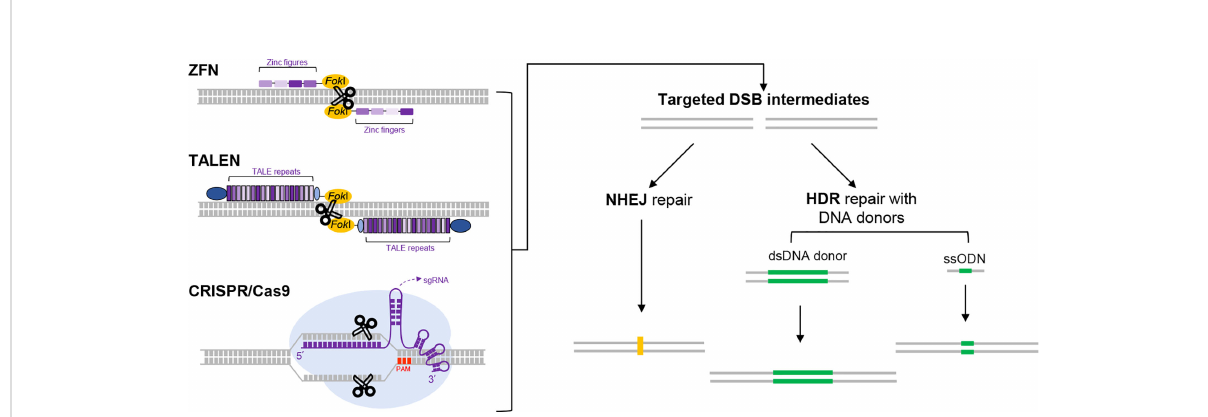
FIGURE 1 The use of programmable nucleases for genome editing. Three major programmable nucleases, i.e., ZFNs, TALENs and CRISPR/Cas9 are schematically illustrated on the left part. ZFNs and TALENs are respectively composed of sequence-speci fi c DNA-binding protein modules linked to a nonspeci fi c DNA cleavage domain (derived from Fok I endonuclease). In ZFNs, an array of zinc fi gures (small blocks in different shades of purple), each speci fi cally recognizing a 3-bp of DNA sequence, are assembled in tandem to program a speci fi c DNA-binding event. In TALENs, variants of TALE repeats correspond to each of the four single bases. Therefore, programmed DNA binding by TALEN is enabled by an assembled array of TALE repeats (dense purple bands). Two other constant domains in TALEN are also depicted in dark and light blue, respectively. For DNA cleavage to occur, the Fok I domain requires dimerization. As a result, only two adjacent targeting events by a pair of targeting ZFN or TALEN monomers in correct orientations would trigger double-strand break (DSB) at a speci fi c locus. The mechanistic principle for CRISPR/Cas9 (a prototype for many CRISPR/Cas tools) is different from those for ZFNs and TALENs. It employs a Cas9 protein and an engineered guide RNA. The Cas9 protein features two nuclease domains, each responsible for cleaving one strand of DNA. The engineered guide RNA (in a form of single guide RNA, sgRNA [purple]) directs Cas9 to the DNA target by base-pairing, which results in generation of a targeted DSB. The target sequence for CRISPR/Cas9 also requires an immediately adjacent PAM sequence (shown in red). Regardless of the nuclease tools used, the DSBs generated would stimulate cellular DNA repair mechanisms (right part), in the form of the error-prone nonhomologous end joining (NHEJ) or homology-directed repair (HDR). The former pathway often leads to uncontrolled insertions or deletions of bases (indels, shown in yellow) around the break site, which tends to cause gene disruptions. The latter pathway engages precise repair directed by homologous donor DNA. In practice, when the cells are supplied with a donor DNA template (either as dsDNA or single strand oligodeoxynucleotides [ssODN] as indicated) containing the desired edits (green) and fl anking homologous regions, the HDR pathway can lead to precise genome editing